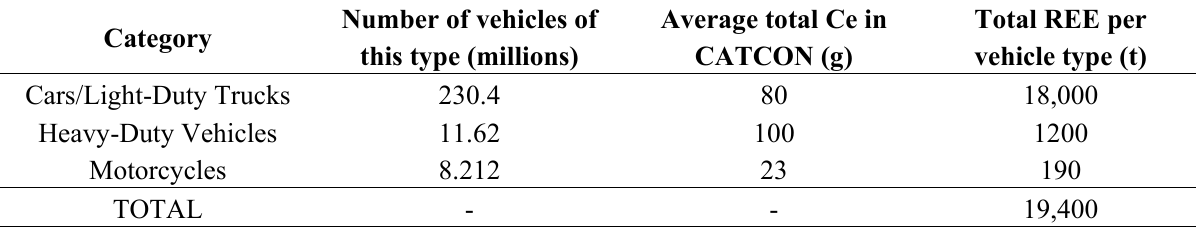
Table 3. Cerium content in CATCONS of different vehicle types as of 2010